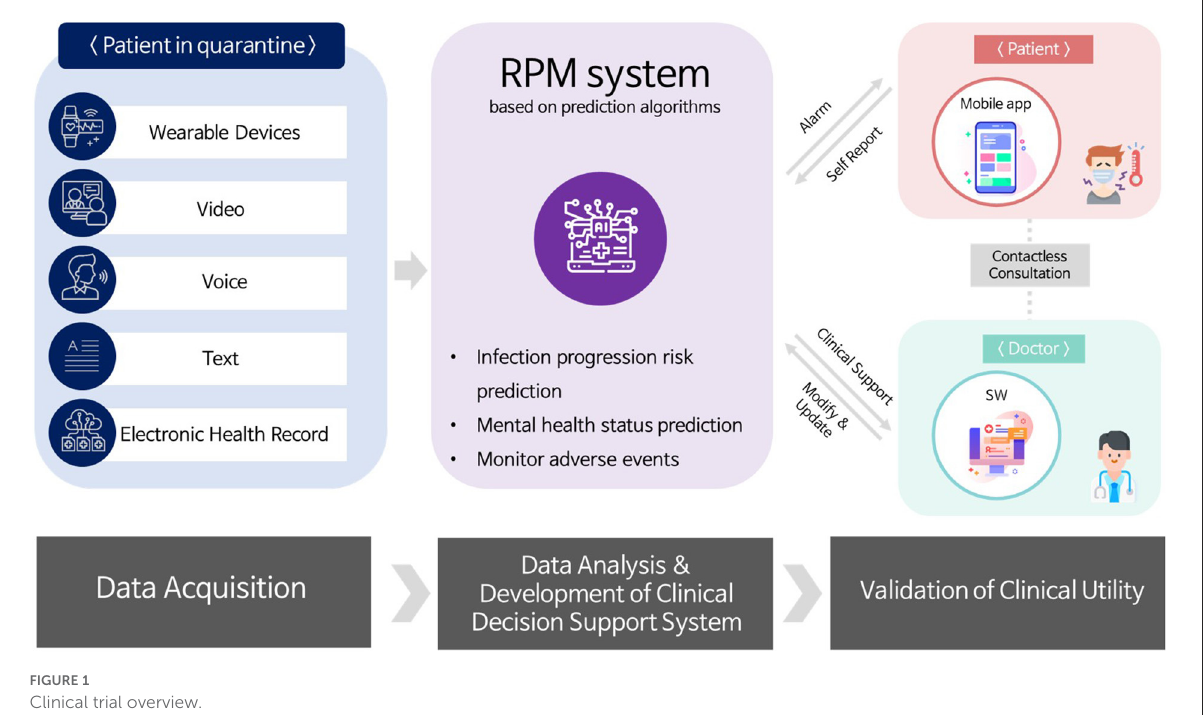
FIGURE1 Clinical trial